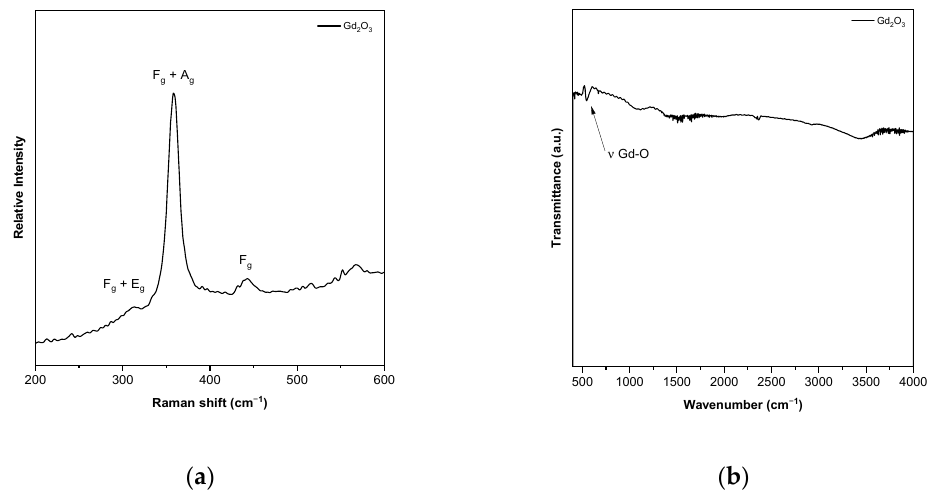
Figure 4. ( a ) Raman spectrum and ( b ) FT-IR spectrum of the Gd 2 O 3